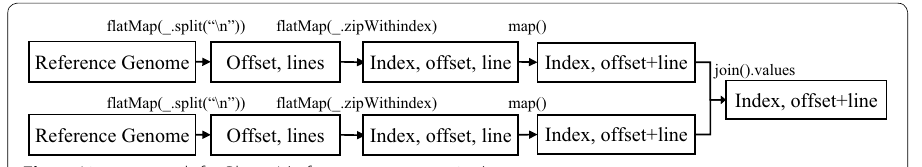
Fig. 1 Lineage graph for Phase I (reference